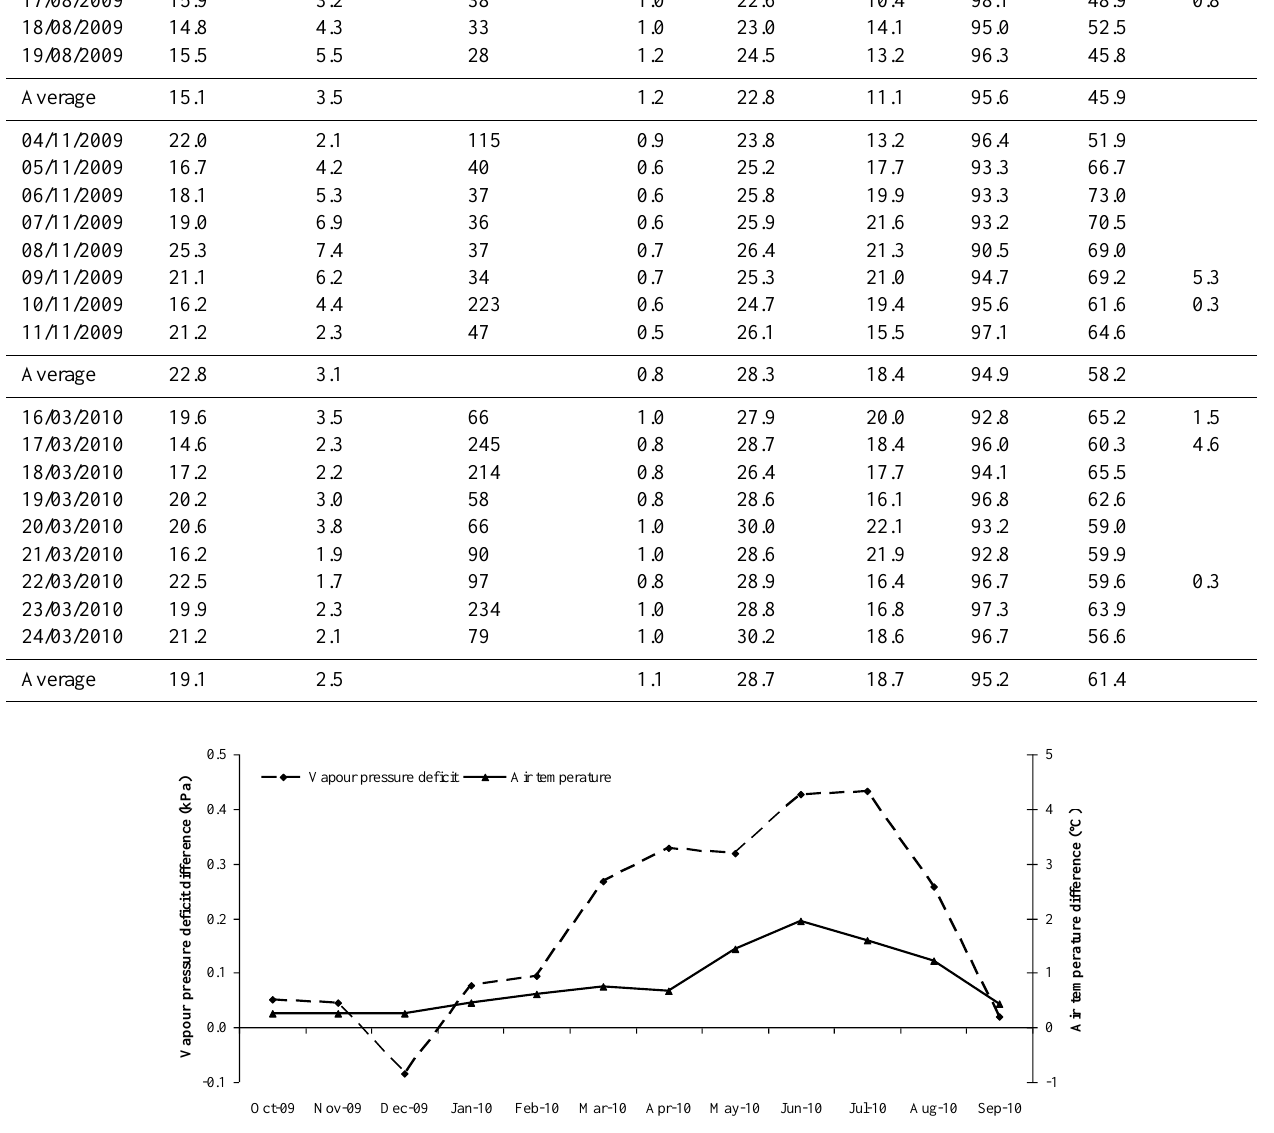
Figure 4. The difference in the monthly daytime (09:00LT to 15:00LT) vapour pressure deficit and difference between the monthly average dawn air temperatures measured in the subtropical freshwater wetland area of the Mfabeni Mire (reeds, sedges and grasses) and within the canopy of the Nkazana Peat Swamp Forest